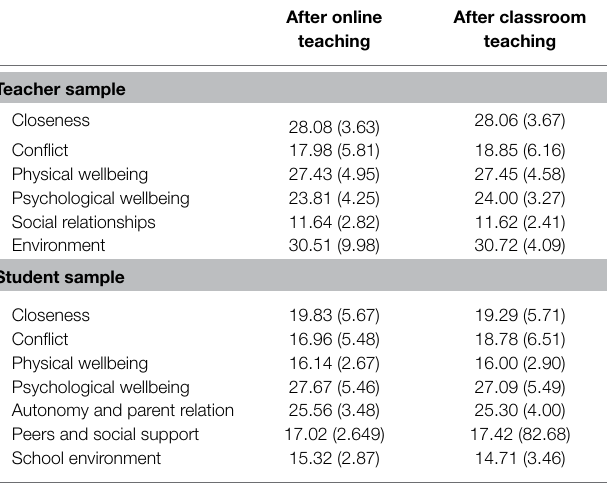
TABLE 1 | Descriptive values for teacher-student relationship and wellbeing, for teachers and for students.